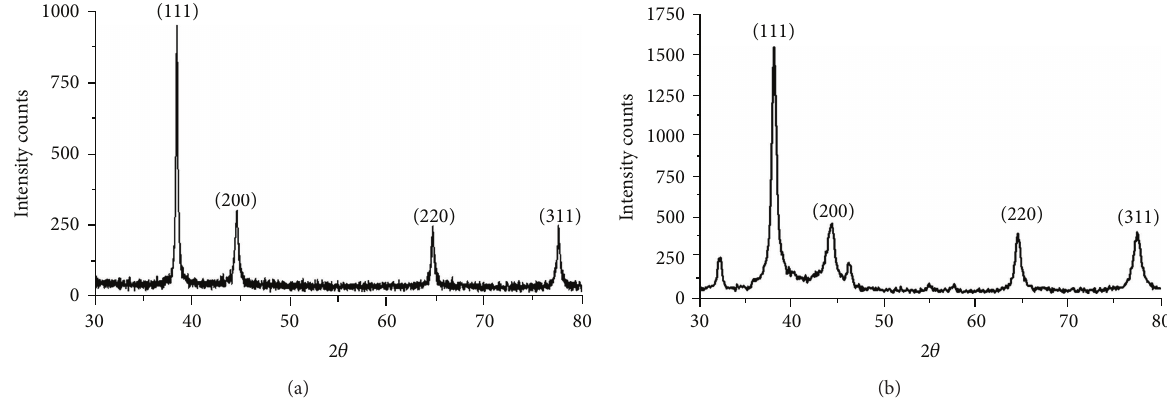
Figure 4: XRD analysis of green-synthesized silver nanoparticles by using leaf (a) and stem extract (b) of Piper nigrum.